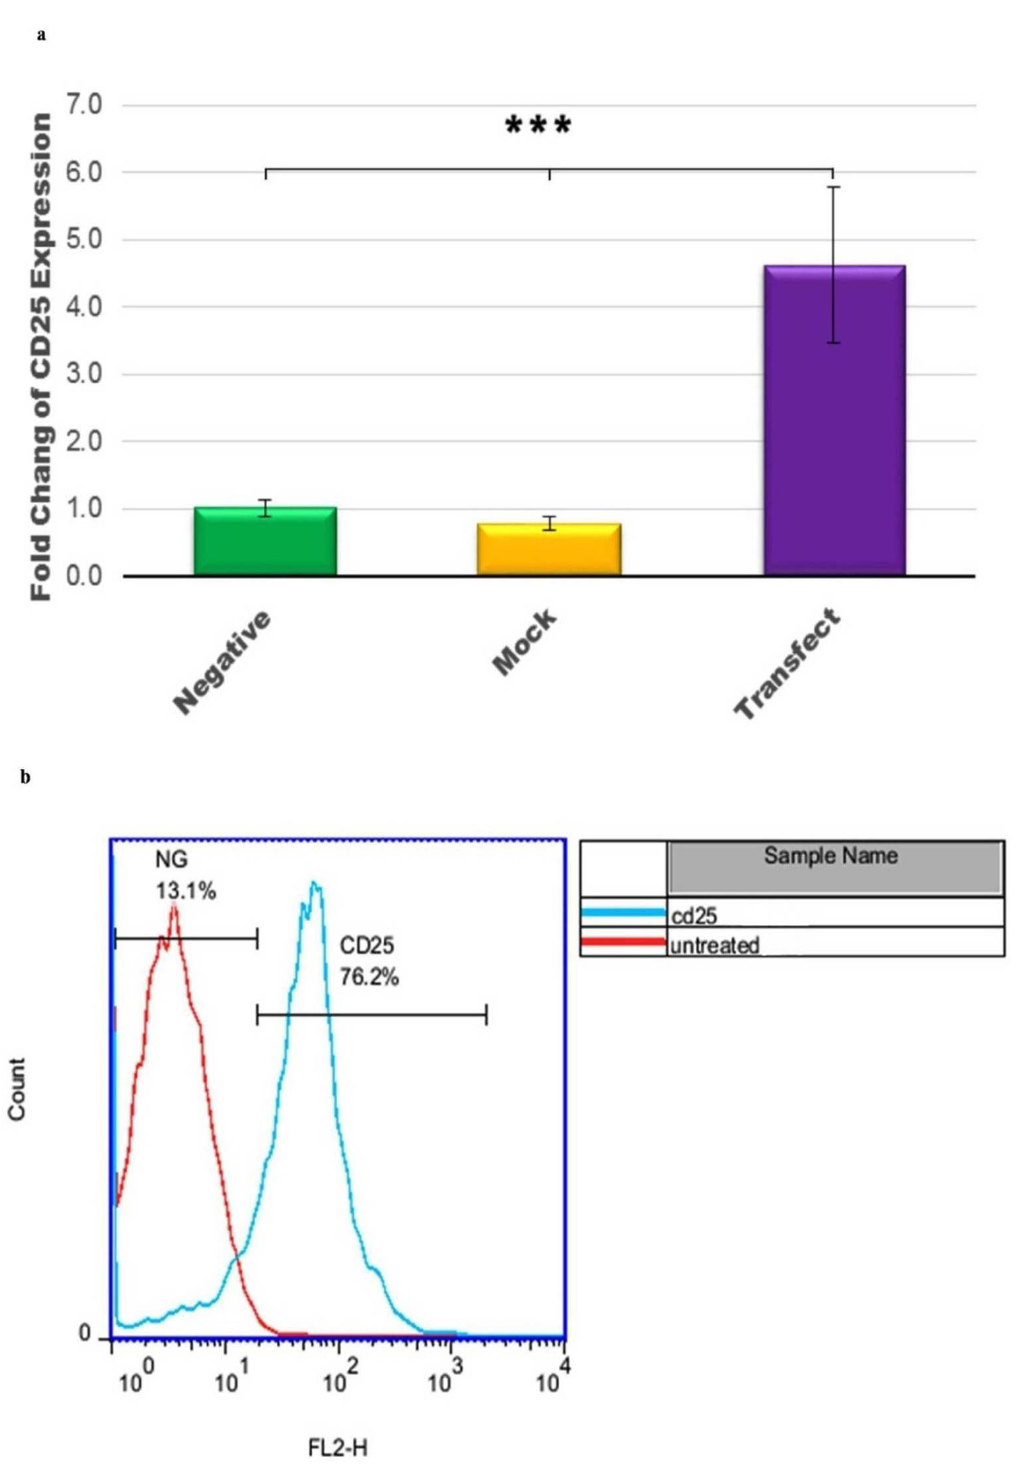
Figure 4: (a) Measurement of CD25 mRNA level in HEK293 cells using qRT-PCR method. CD25 is highly expressed in transfected HEK293 cells while it is almost undetectable in negative control (untransfected) and Mock. Asterisk (*) represents statistical significance ( p < 0.001). Results are shown as mean ± SEM obtained from three identical repeats of each experiment. (b) Flow cytometry analysis of CD25 expression on the cellular surface of HEK293 cell line. The histogram shows 76.2% of the cells are expressing